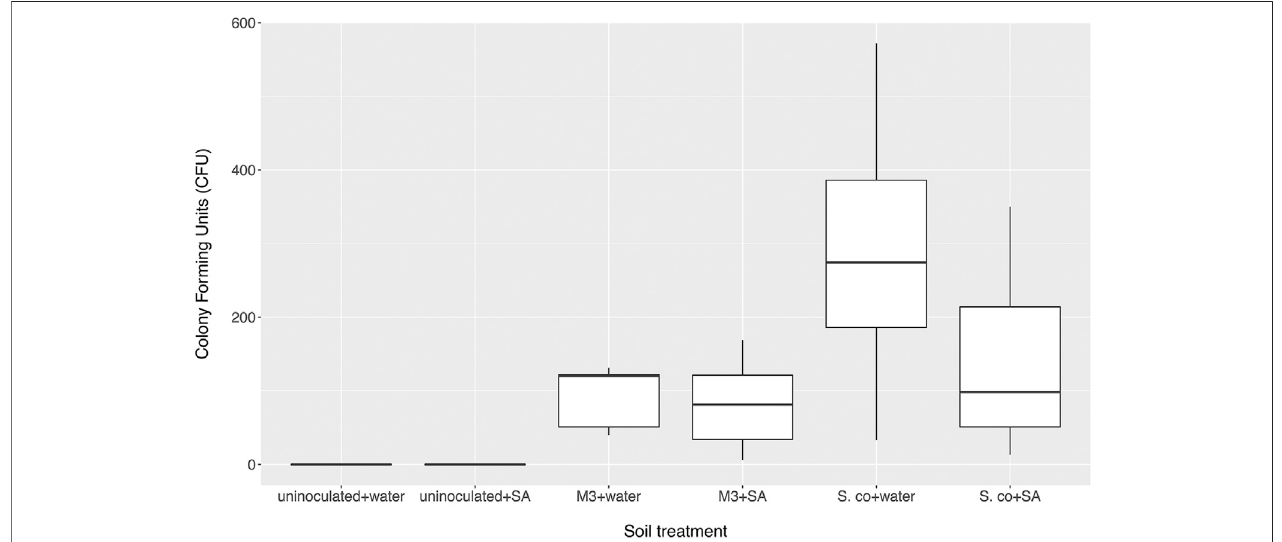
FIGURE2| Numberofcolonyforming units(CFU)ofinoculated Streptomycescoelicolor M145or Streptomyces M3strainsreturnedfrom soilmicrocosmstreated with either salicylic acid (SA) or distilled water after 10 days. Control microcosms weren ’ t inoculated. N (cid:2) 9 microcosms per treatment.